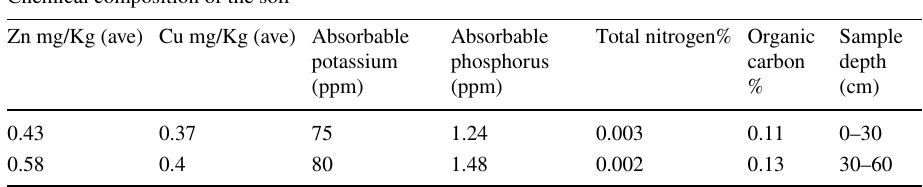
Chemical composition of the soil